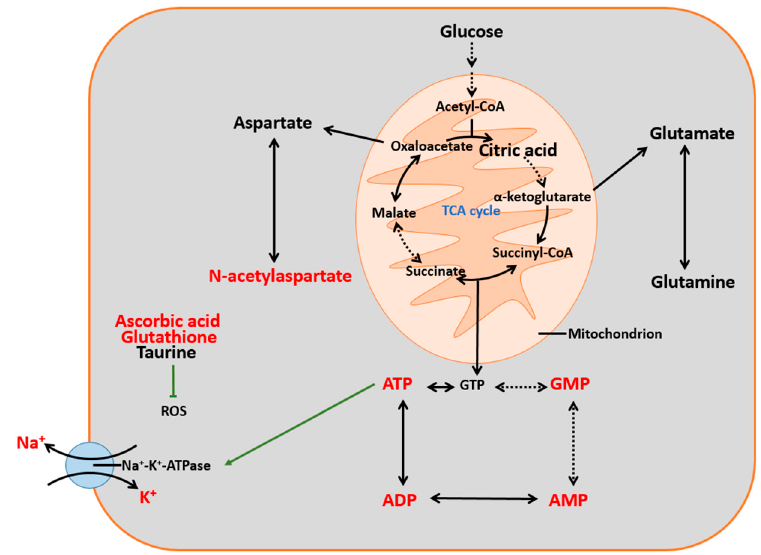
Figure 9. A summary of the molecules of interest in this study. Molecules in red were observed by MALDI–TOF–MS imaging and did not conflict with the results of MRM MS. Dl-3-n-butylphthalide can lower the levels of sodium ions, while increasing the levels of the other seven molecules. Black arrows indicate metabolic process. The green arrow indicates promotion, and the green T-shaped line indicates inhibition. Dashed arrows indicate omission of intermediate